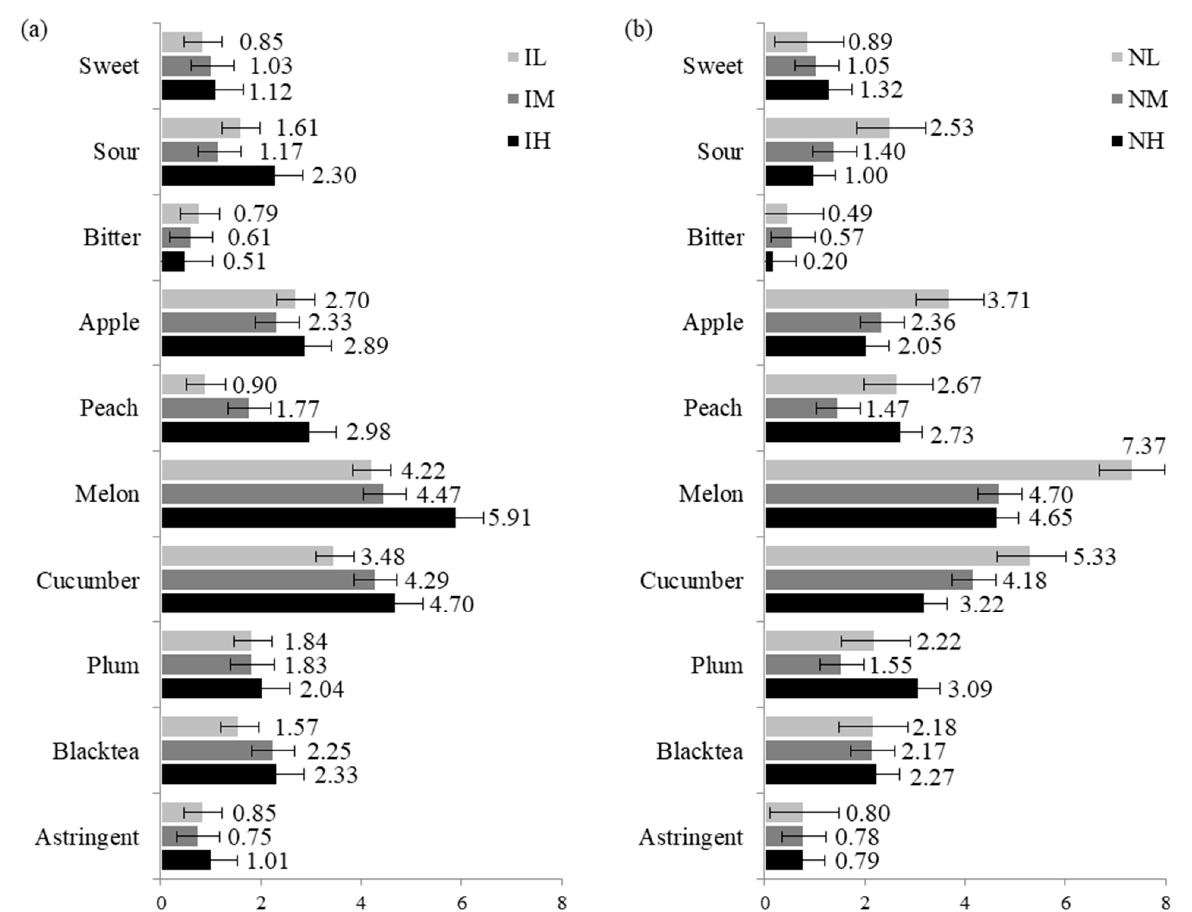
Figure 2. The range magnitude of the group mean value for each level of the ( a ) PII and ( b ) FNS measures for the intensities of the attributes: the maximum value minus the minimum value within each attribute and groups. Bars represent standard error.